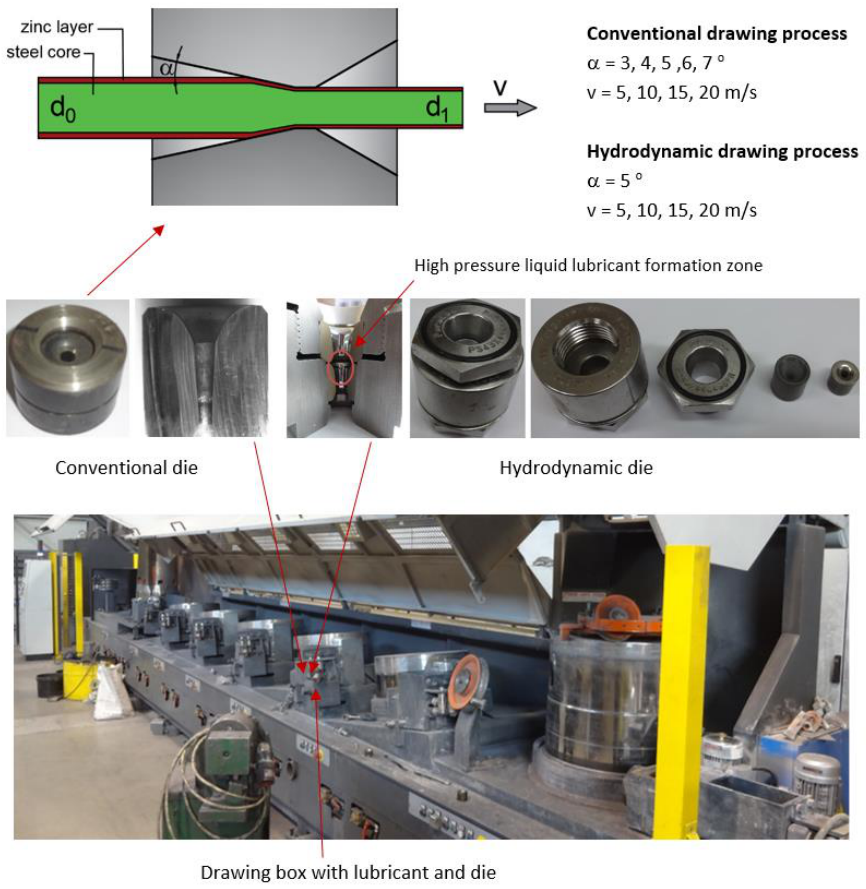
Figure 1. Model and parameters of the zinc-coated steel wire drawing process using a Mario Frigerio multi-stage drawing machine, where α —the angle of the die compression zone, v—drawing speed, d 0 , d 1 — initial and end diameter of the wire.